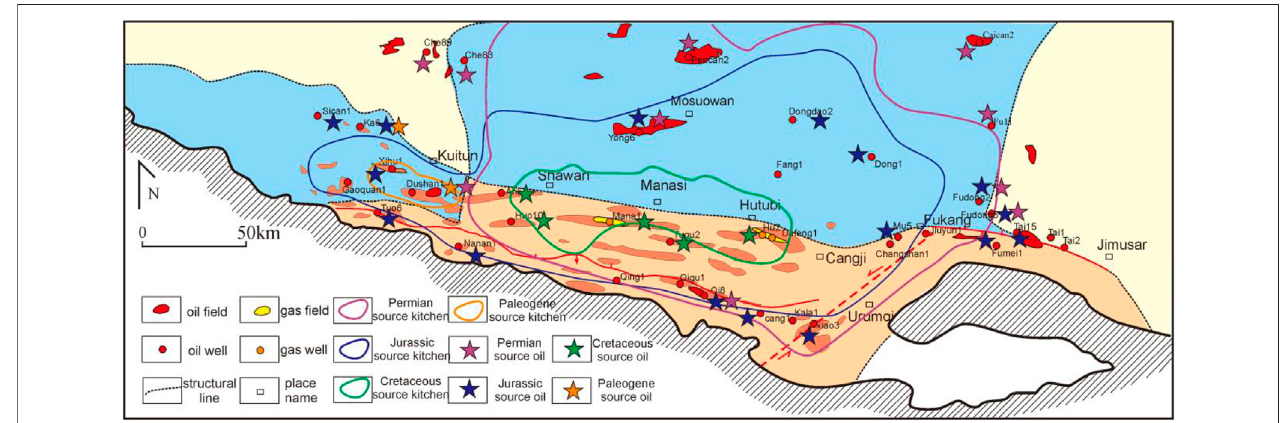
FIGURE 4 | Map showing the distribution of the four sets of effective source rock and four types of oil in the South Junggar foreland basin.